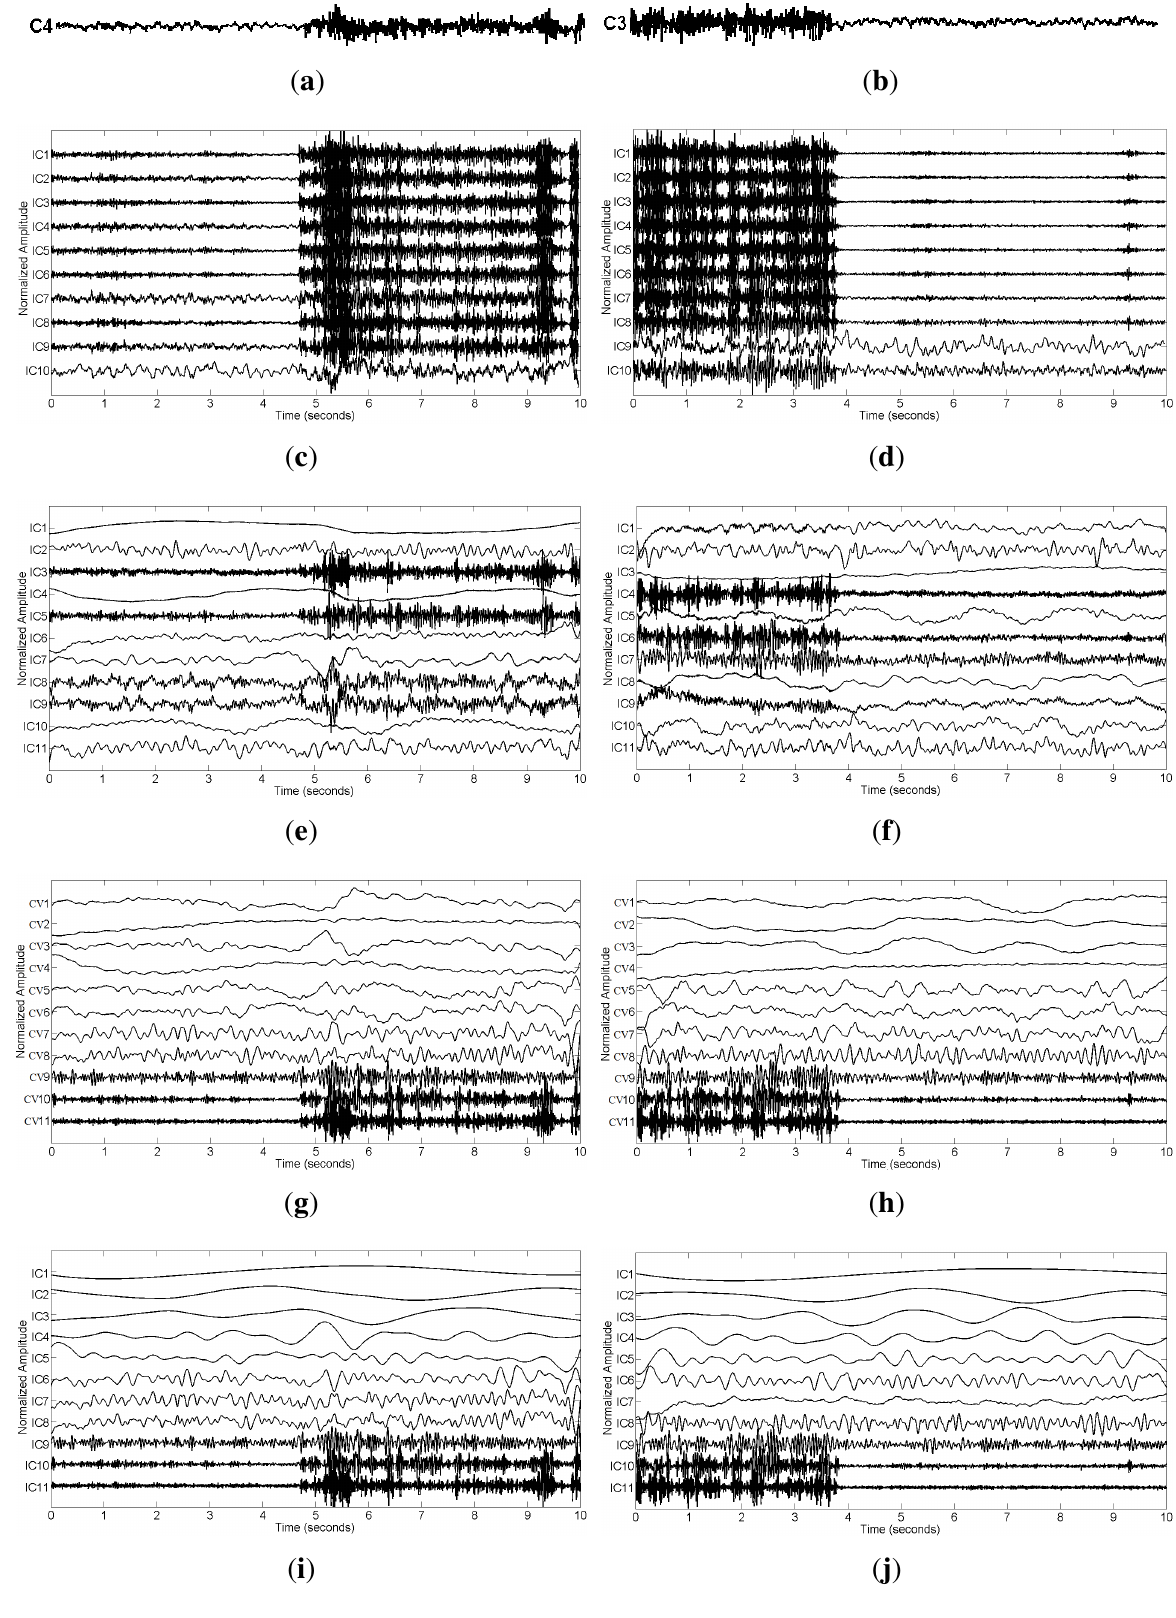
Figure 7. The decomposition components of EEG signals in ( a ) C4 and ( b ) C3 obtained using the four methods: SCICA for ( c ) C4 and ( d ) C3; EEMD-ICA for ( e ) C4 and ( f ) C3; EEMD-CCA for ( g ) C4 and ( h ) C3; EEMD-IVA for ( i ) C4 and ( j )